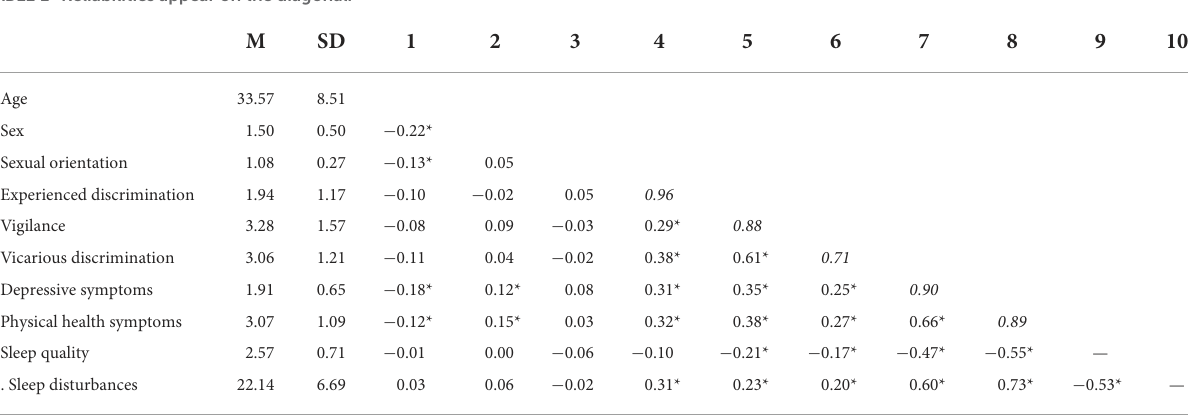
TABLE 1 Reliabilities appear on the diagonal.